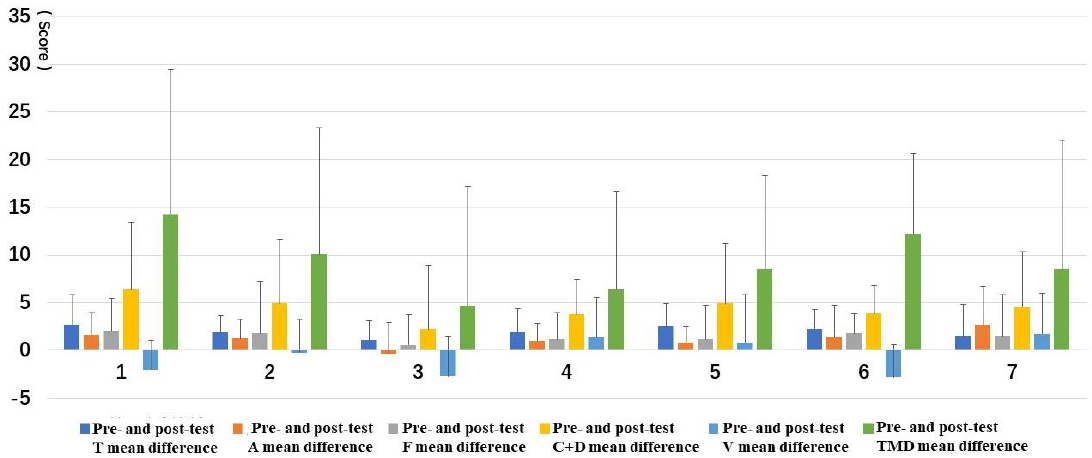
Figure 10. The mean value of the ∆ D of the BPOMS: ( 1 ) structure, ( 2 ) wood, ( 3 ) wood with bench, ( 4 ) wood with platform and bench, ( 5 ) platform with trees, ( 6 ) waterfall with trees, and ( 7 ) pool with plants. T—tension, A—anxiety, F2014fatigue, V—vigor, C + D—confusion-depression.